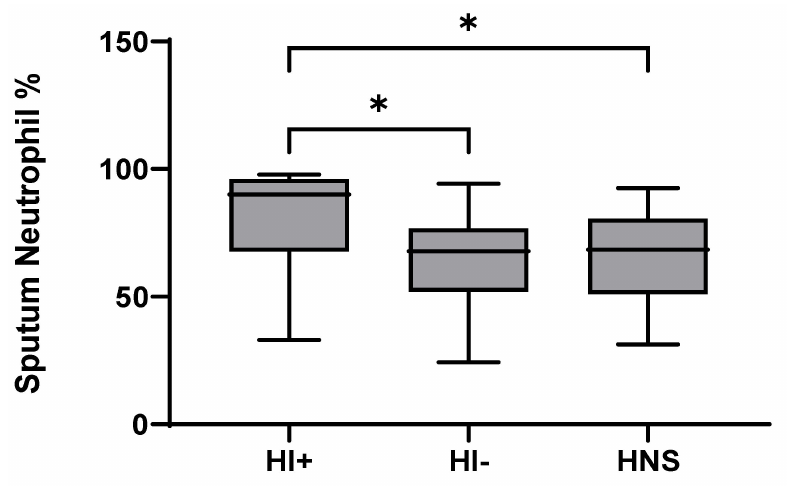
Figure 4. Sputum Neutrophil Percentage in COPD HI +ve, COPD HI − ve and HNS : Data is pre- sented as minimum, maximum and median concentrations, data analysed using Krushkal-Wallis test with Dunns post hoc test. * p ≤ 0.05.